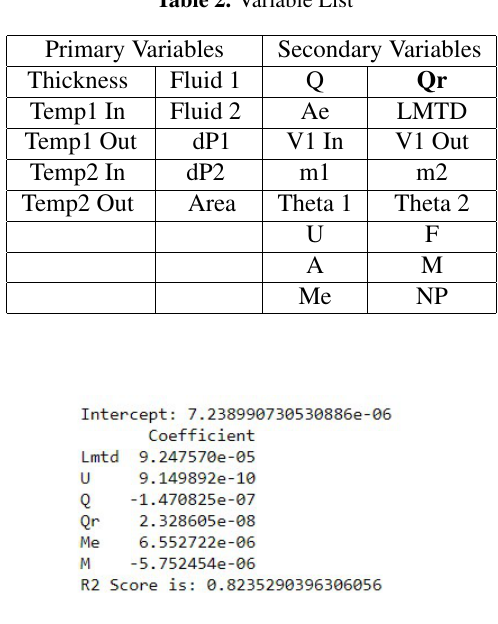
Figure 11. R2 Score for plate heat